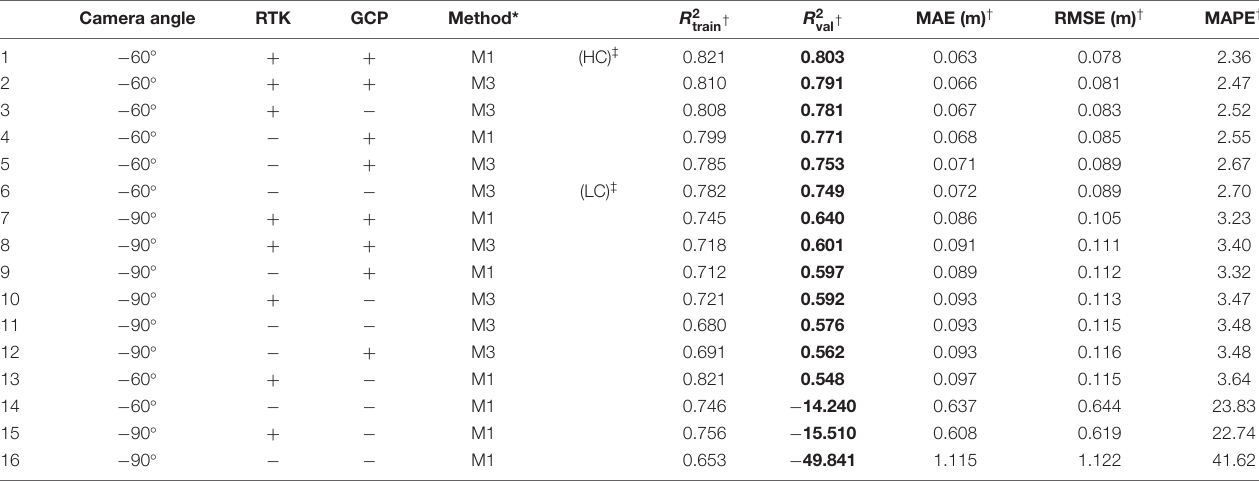
TABLE 8 | Evaluation metrics on cross-validation of PH regression models in the reproductive stage of Field